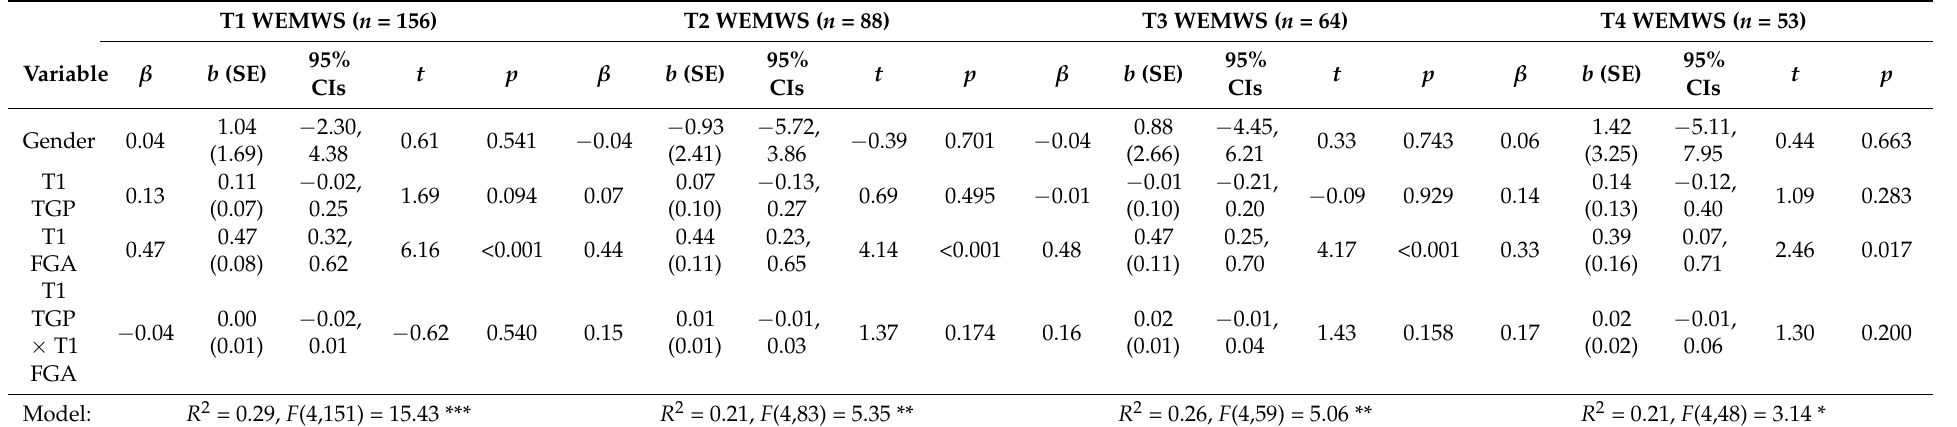
Table 2. Tenacious goal pursuit and flexible goal adjustment as predictors of T1 to T4 wellbeing.